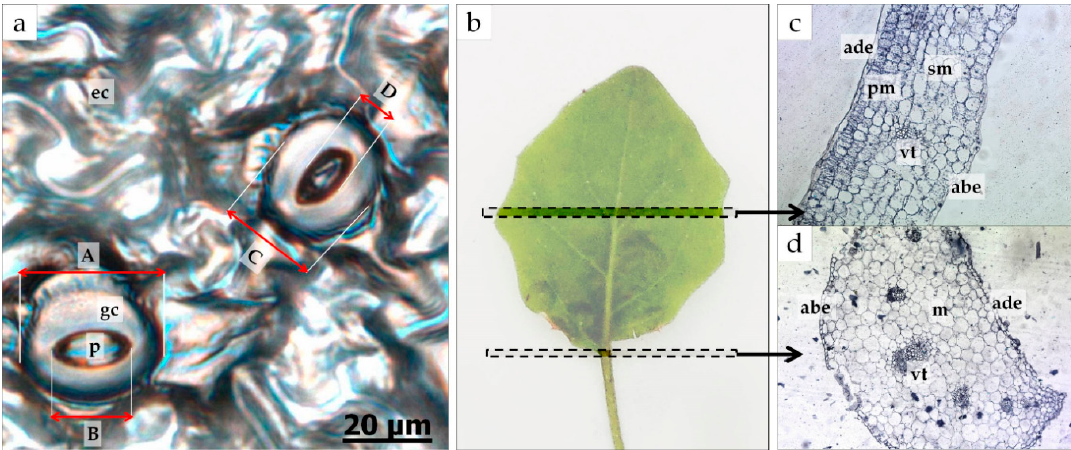
Figure 1. Leaf analysis: ( a ) stomata measurements—A, stomata length; B, pore length; C, stomata